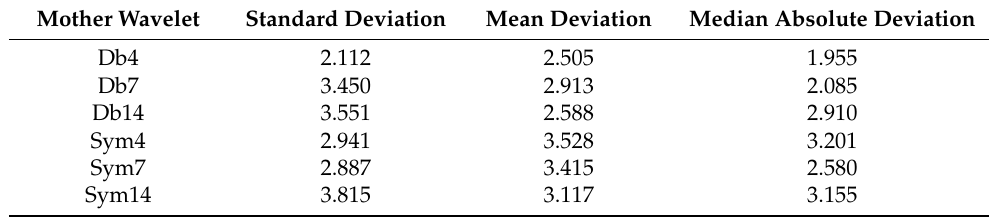
Table 2. Selection of mother